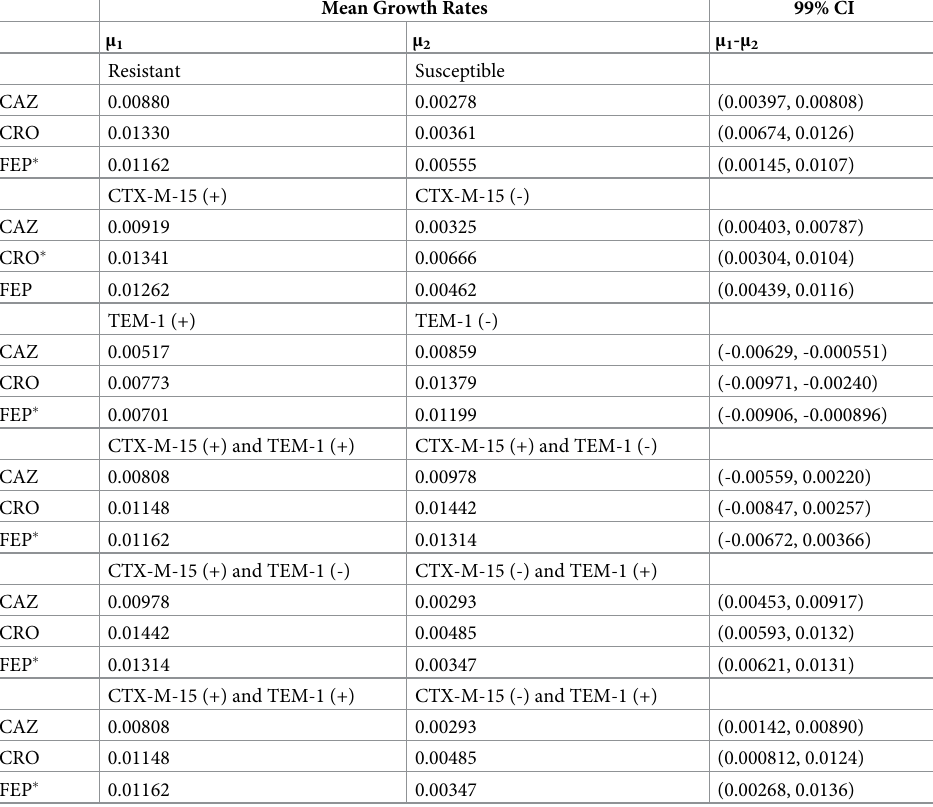
Table 4. Average growth rates (min -1 ) for all conditions. Mean isolate growth rates and 99% confidence intervals (CI) for the difference in mean growth rates based on a